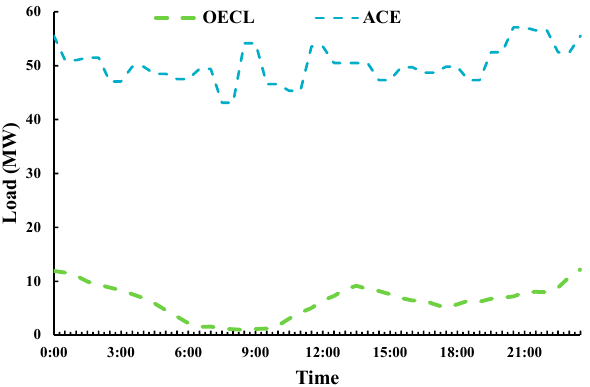
Figure 13. Profiles of the ACE and optimized EV charging load (OECL).